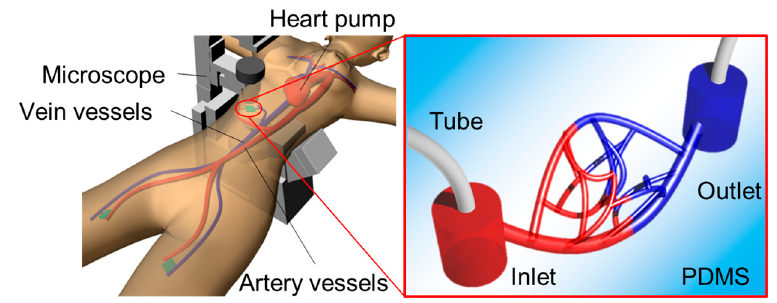
Figure 1. Concept of simulating capillary vessels and arterioles with models.